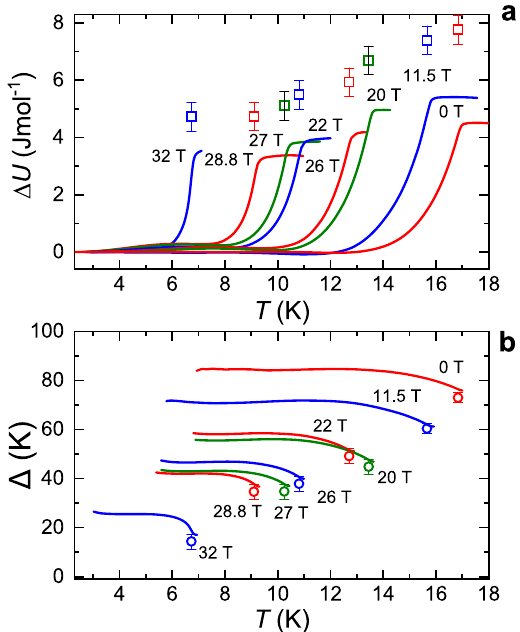
Fig. 10 Comparison of Δ U and Δ estimates. a A comparison of the estimated change in internal energy Δ U ( T ) (lines) integrated using Eq. (12), should the transition be of weakly fi rst order, with Δ U ( T = T o ) (open squares) at the transition estimated using Eq. (13). b A comparison Δ ( T ) (lines) estimated using Eq. (14), should the upturn in C exp be caused by a temperature-dependent gap, with Δ at the transition (open circles) obtained by setting Δ U = 0 in Eq. (13). All error bars refer to the standard error of the